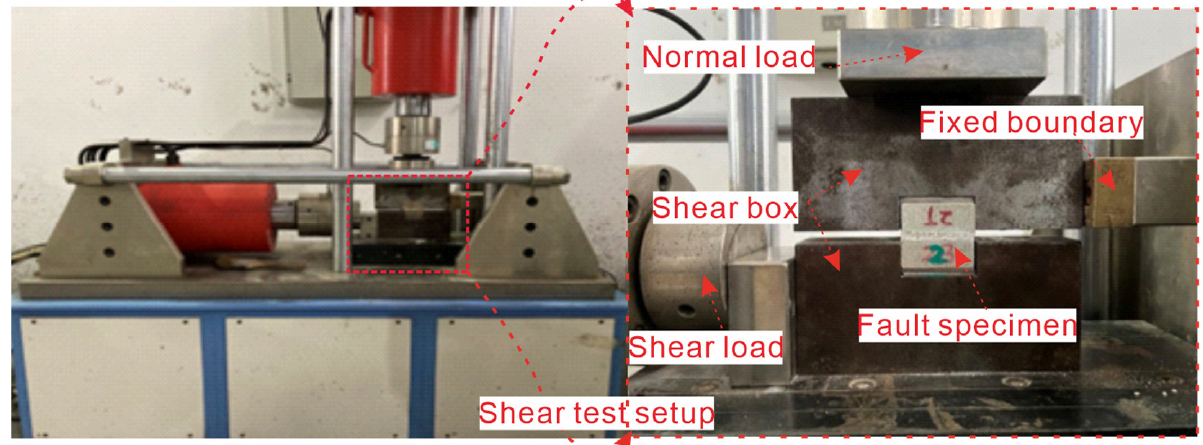
Figure 2. RJST-616 Shearing device.